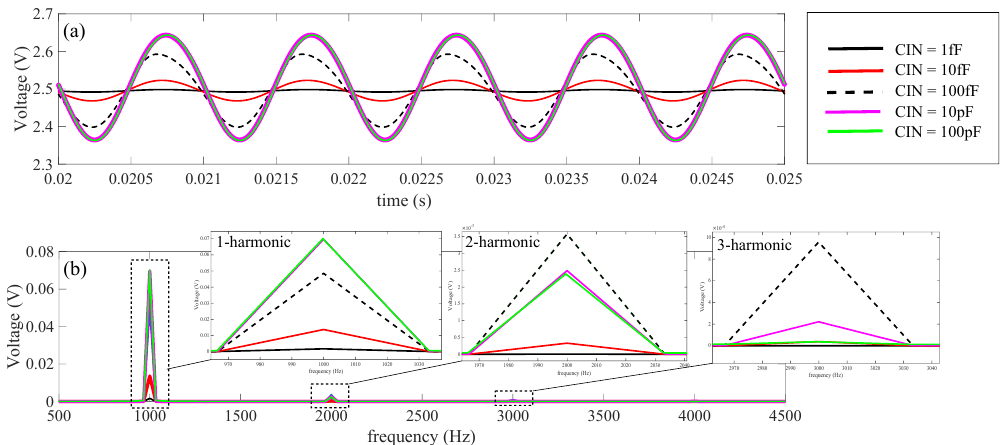
Figure 14. Analysis of non linearities in PFGA2 during a sweep in the value of C IN = 1fF, 10fF,100fF,10fF,100fF. ( a ) Time analysis ( b ) Fast Fourier Transform (FFT)